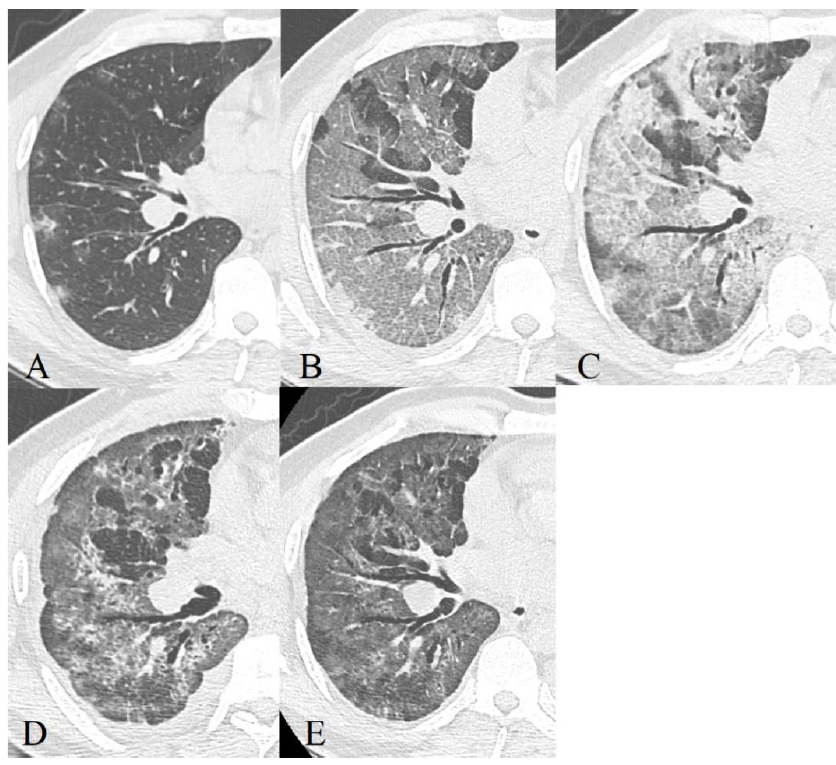
Figure 8. 44-year-old patient, m, 11.04 symptom onset, 17.04 PCR+, AT к Il -6 used for therapy, images obtained 16.04 ( A ), 21.04 ( B ), 24.04 ( C ), 13.05 ( D ), 21.05 ( E ), recovered.